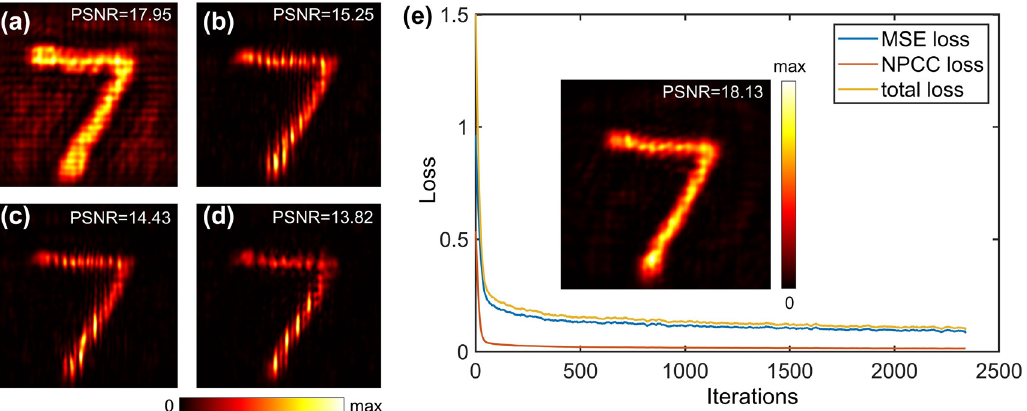
Figure 5: Intensity distribution of reconstructive images when the intensity of target images is normalized to different values. (a) – (d) FDTD results of normalization to 1, 5, 7 and 9, respectively. (e) Loss curve of the best reconstructive performance when the intensity of target images is normalized to 3 (Inset). The total loss decreases to 0.095 after ∼ 2000 iterations.